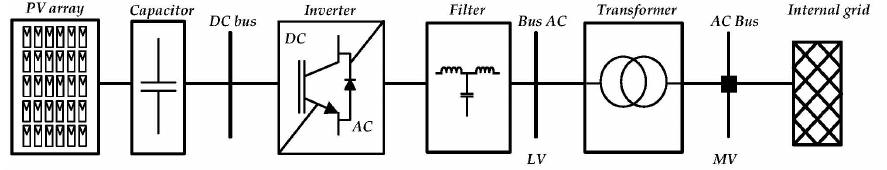
Figure 3. PV generator in central configuration.